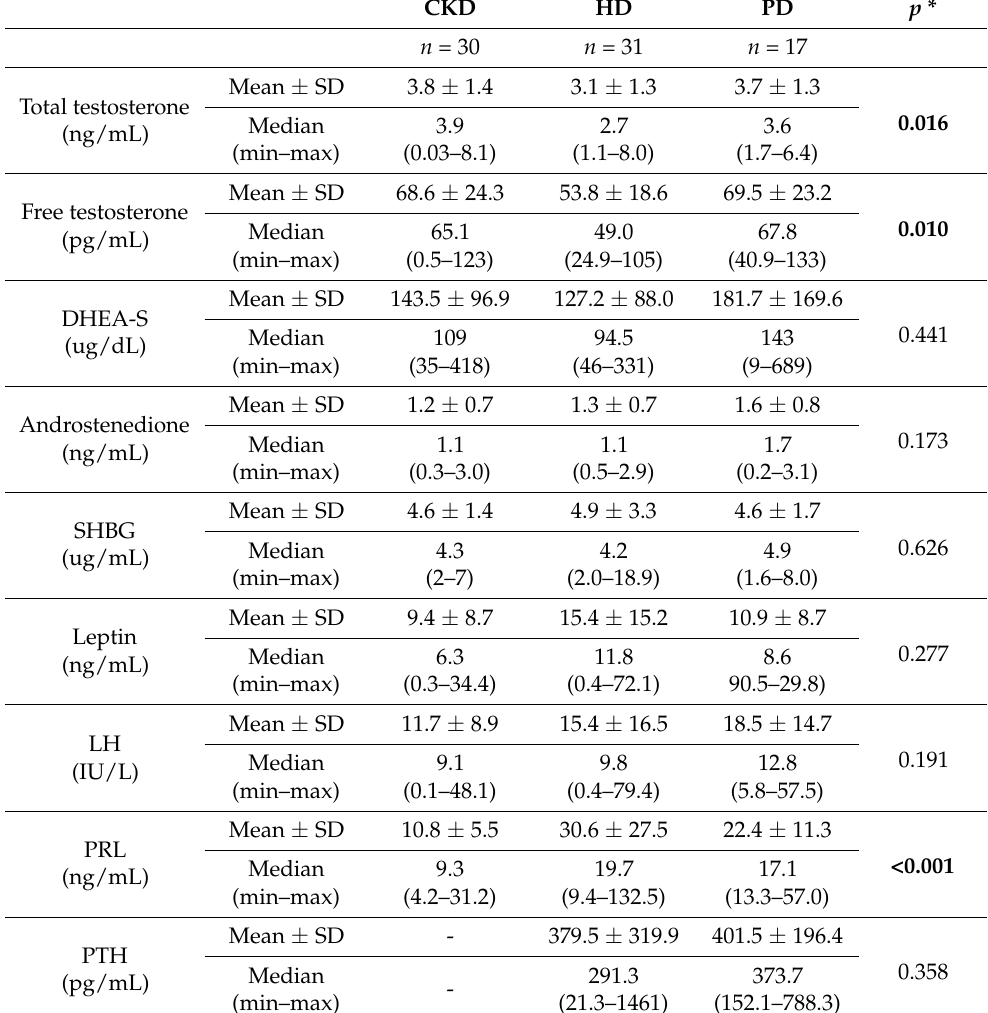
Table 3. Assessment of the hormonal profile in the studied groups of